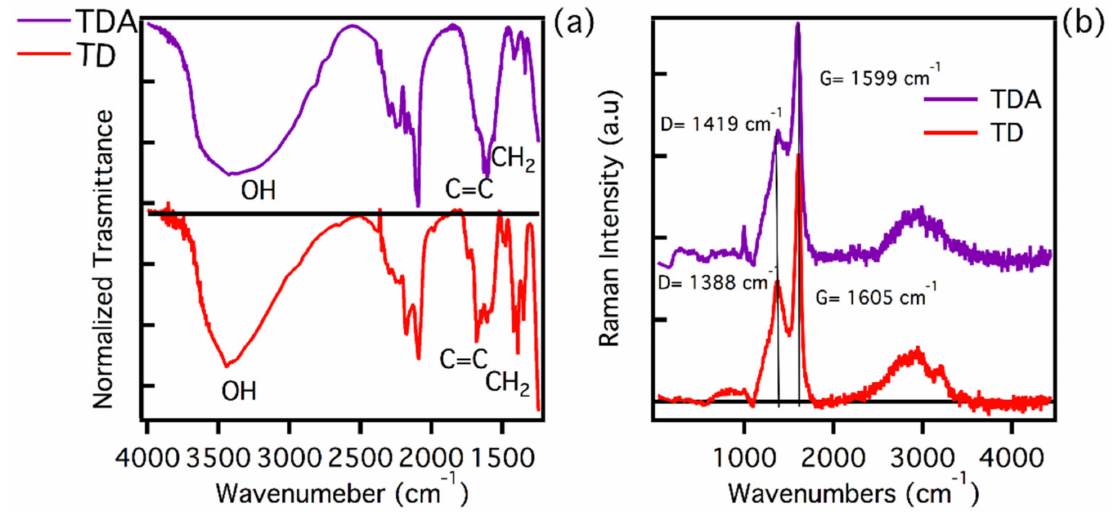
Figure 1. ( a ) FT-IR spectra of TD (red line) and TDA (purple line) samples. ( b ) Normalized Raman spectra of TD (red line) and TDA (purple line) samples. FT-IR and Raman spectra have been arbitrarily vertically shifted for clarity. The arrow in the top portion of panel ( a ) marks the spectral range of CH 2 bending